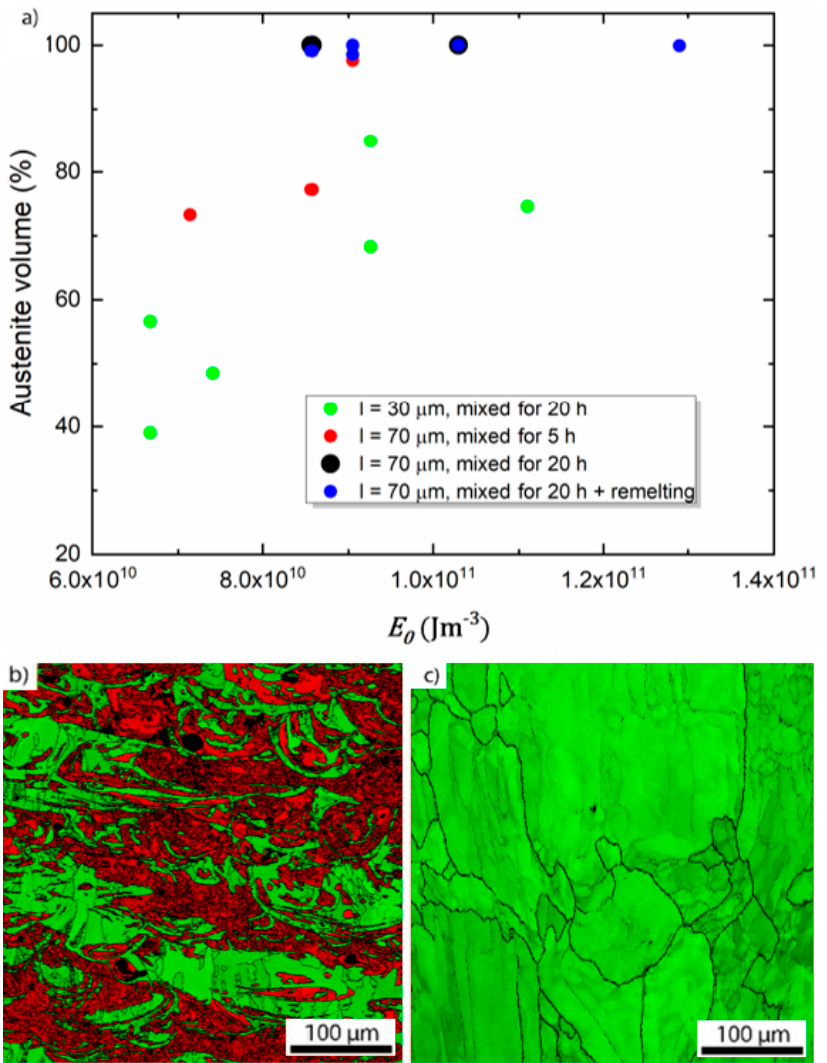
Figure 4. ( a ) Austenite volume fraction as a function of E o obtained from EBSD measurements. EBSD map for sample parameters Q = 300 W, v = 1.5 m / s, h = 80 µ m, l = 30 µ m, and r b = 45 µ m ( b ). (red: ferrite, green: austenite). EBSD map for sample parameters Q = 360 W, v = 0.25 m / s, h = 120 µ m, l = 70 µ m, r b = 100 µ m and re-melting ( c ). (fully austenitic). Building direction is upward for all